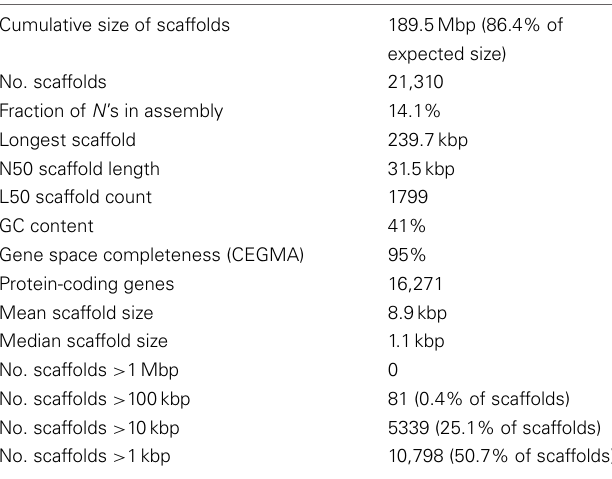
Table 1 | Summary statistics of assembly and annotation of the genome of flax rust pathogen Melampsora lini isolate